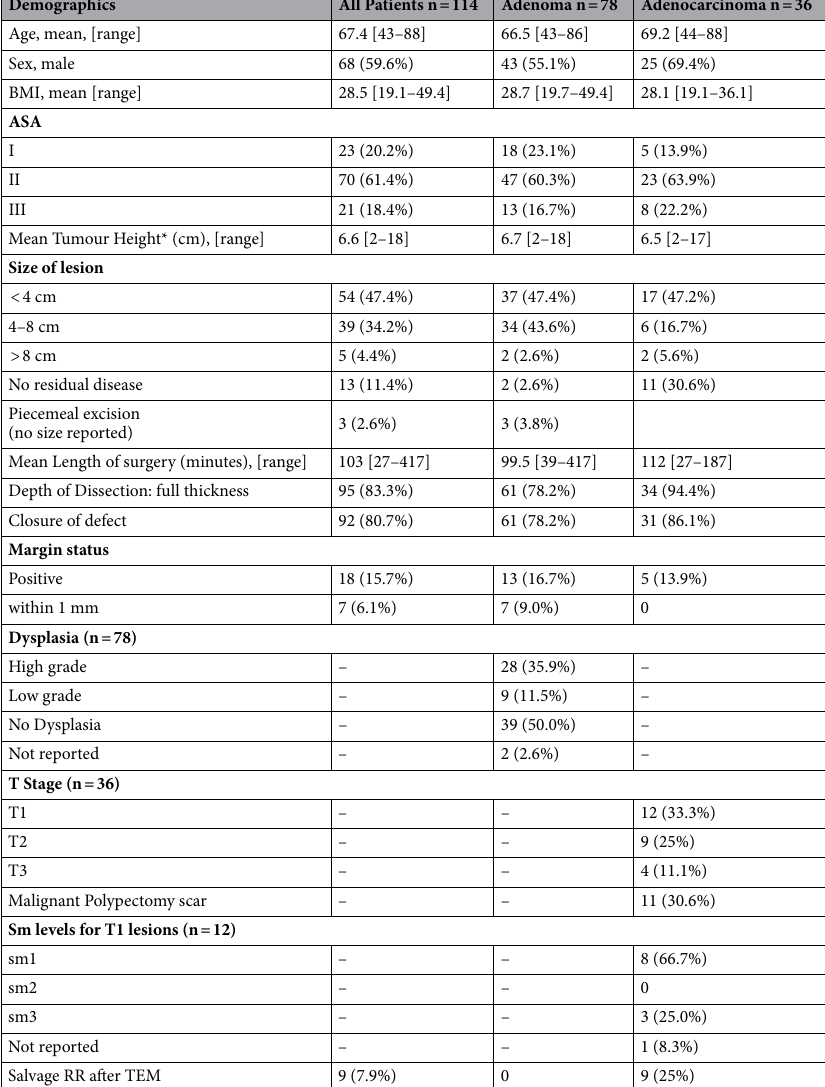
Table 1. Patient demographics, tumour factors and operative/post-operative results. *data on tumour height was only available in n = 88 patients.